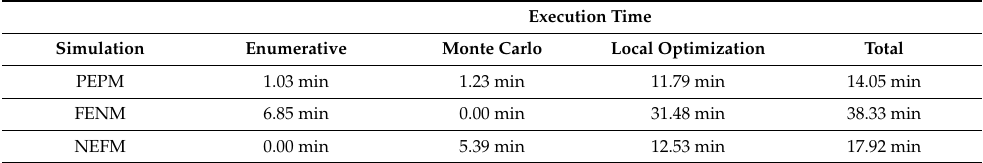
Table 5. Average execution time for each